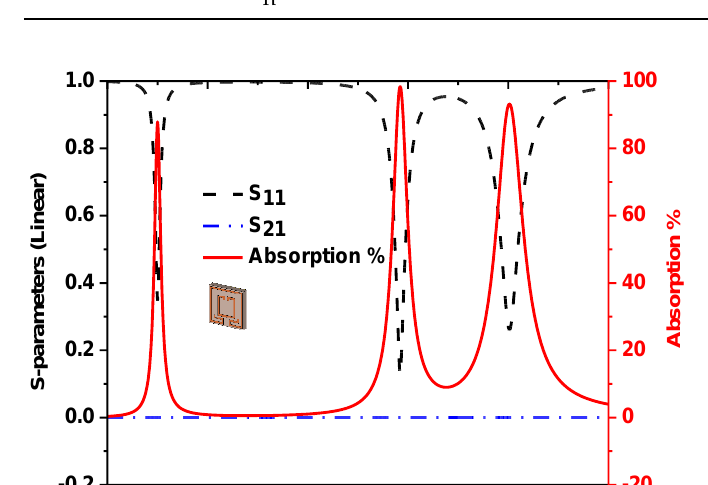
Figure 1. ( a ) Perspective view and ( b ) Simulation setup of proposed MMA.